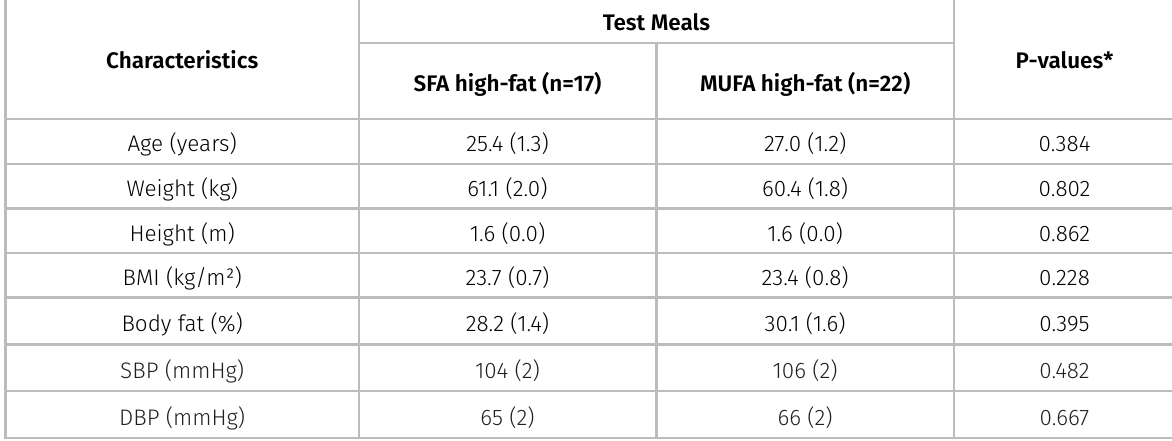
Table I. Summary of characteristics of study participants.